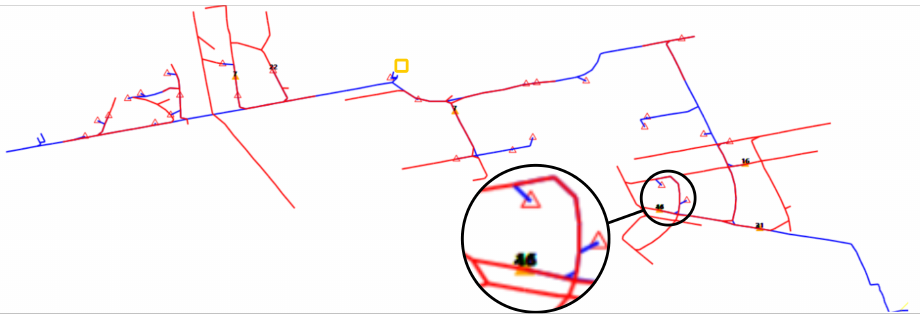
Figure 6. Feeder- β medium and low voltage circuit